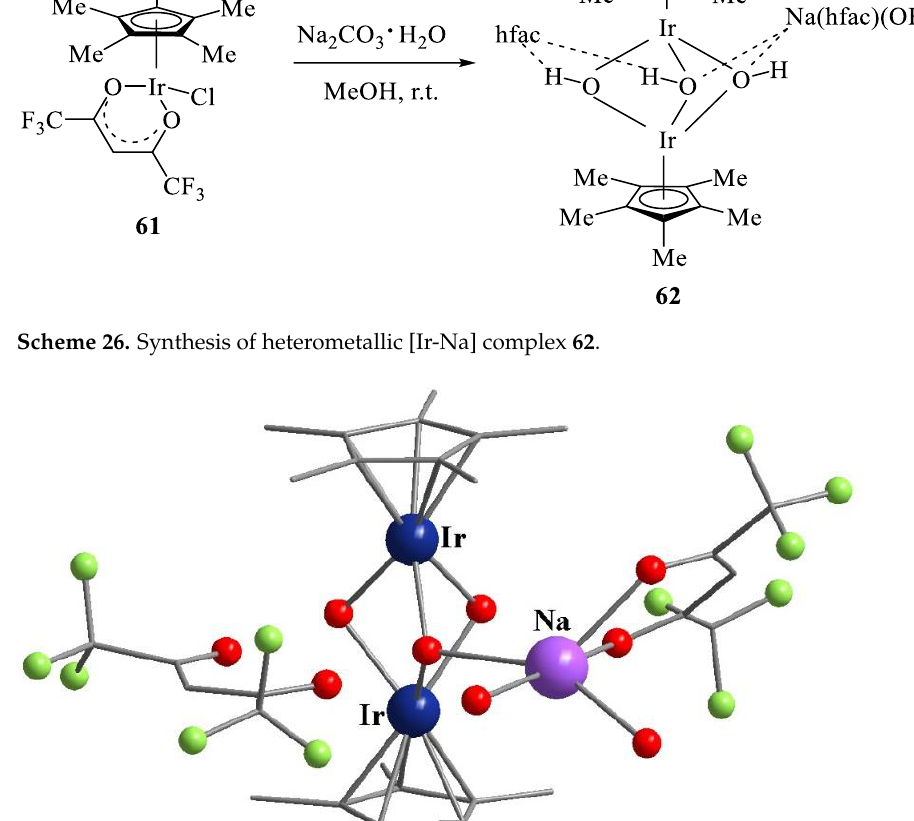
The trifluoromethyl β -diketone HL 1 with dithienylethene substituent was used as a ligand in the synthesis of heterometallic [Yb-Ru] complex 63 exhibiting the redox/optical control of emission (Figure 32) [51]. The bimetallic complex 63 was formed due to the coordination of the tris - β -diketonate Yb( L 1 ) 3 fragment with the functionalized 2,2 ′ -bipyri- dine containing a ruthenium(III) ion.